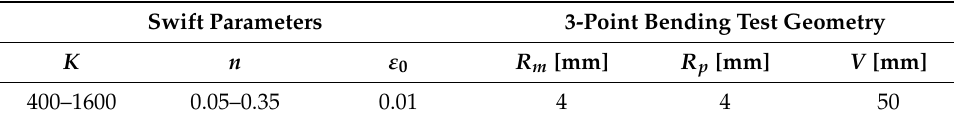
Table 1. Swift parameters and bending test geometry used in problem (a). Swift